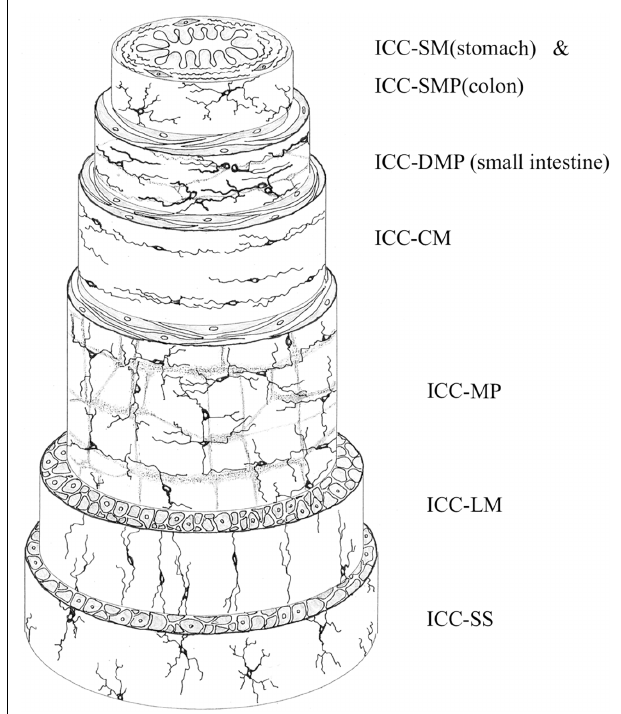
FIGURE 2 | Schematic of the location of ICC within the different layers of the GI tract. ICC-SM and ICC-SMP are the innermost ICC, located at the border of the submucosa and circular muscle. ICC-DMP occur between circular muscle layers in the small intestine. ICC-CM and ICC-LM are located within circular and longitudinal muscle, respectively. ICC-MP (ICC-MY) are located between the circular and longitudinal muscle layers. ICC-SS occur within the subserosa. Reproduced from Hanani et al. (2005) with permission from